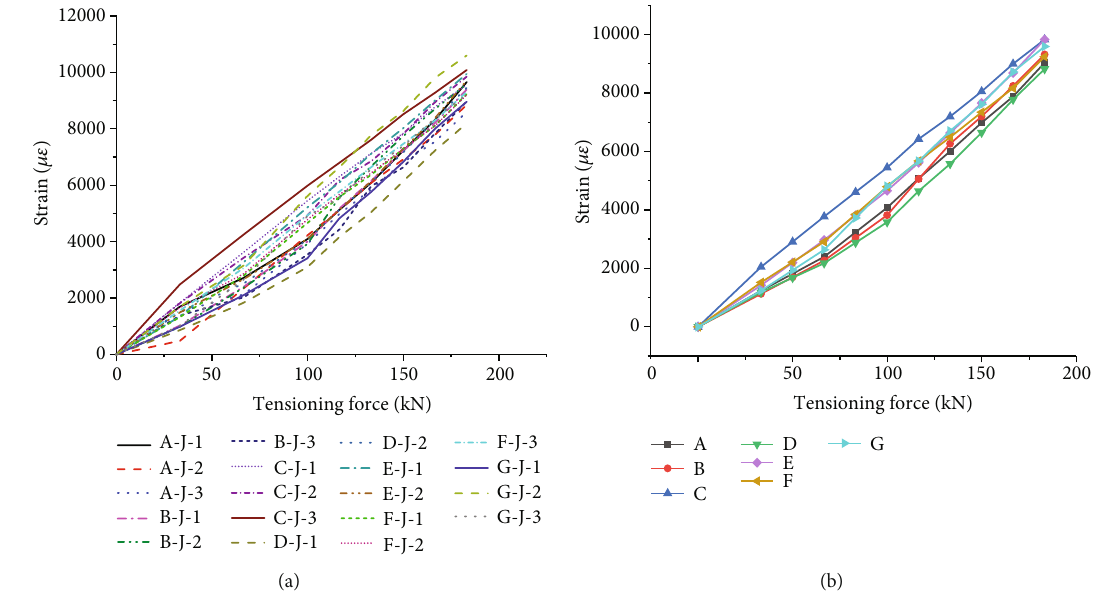
Figure 8: The relationship between the strain and the tensioning force: (a) all the BFRP tendons and (b) average for each of the seven bunches.